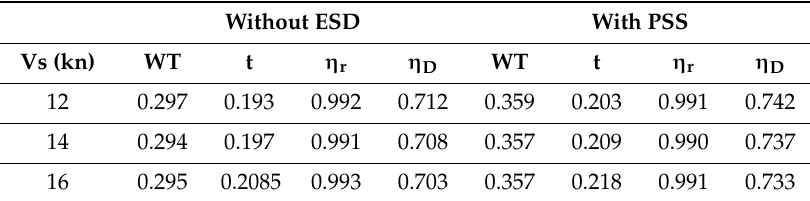
Table 7. Computed propulsion coefficients of the vessel without ESD and with the designed PSS. (PSS-Var-5, full scale).